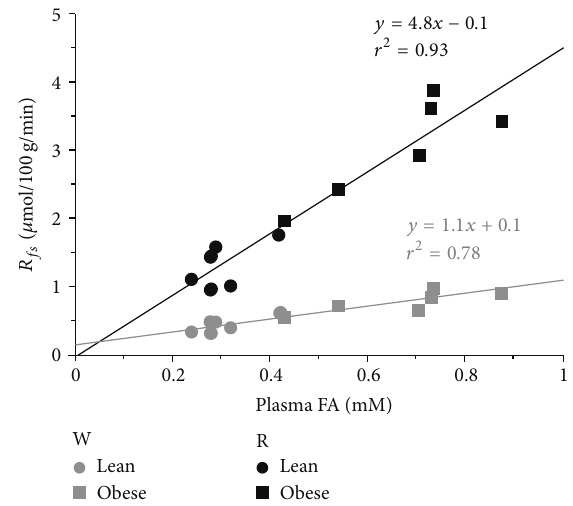
Figure 2: Relationship between in vivo flux of FA into storage in skeletal muscle and plasma FA level. Circles represent results from Lean, while squares represent results from Obese animals. Results for white quadriceps muscle (gray symbols, W) and red quadriceps muscle (black symbols, R) are plotted for individual animals ( 𝑛 = 6 rats per group). Straight lines represent linear regression